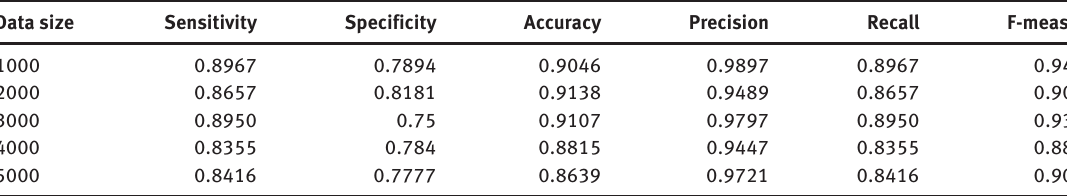
Table 1: Performance Analysis by Varying Data